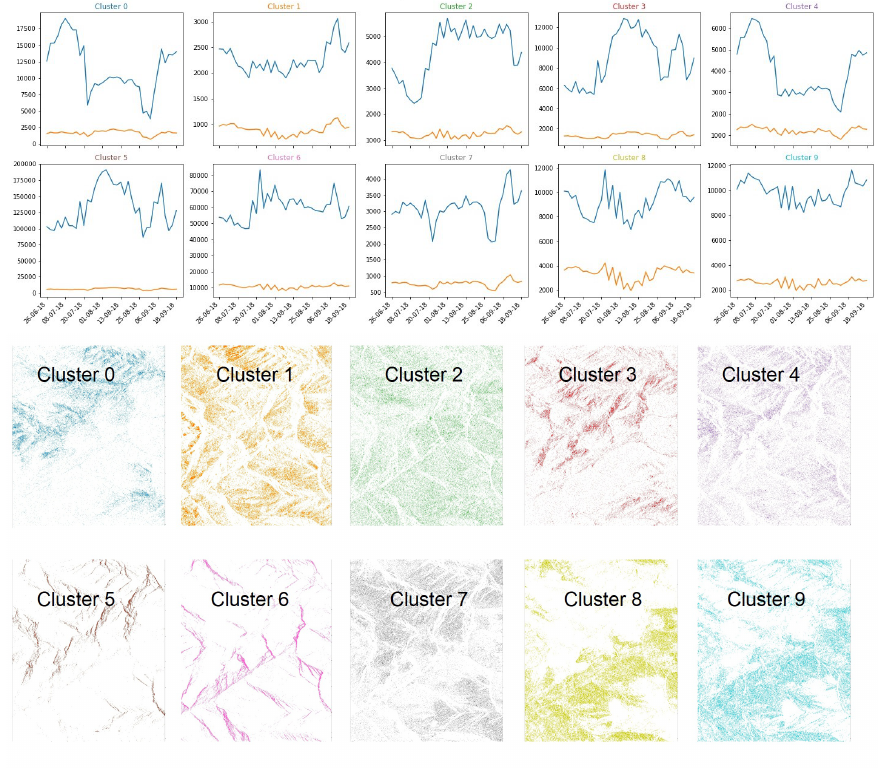
Figure 12. Typical intensity profiles obtained for the 10 K-means clustering classes, and their spatial distribution on the image. In blue: VV profiles, in orange: VH polarization